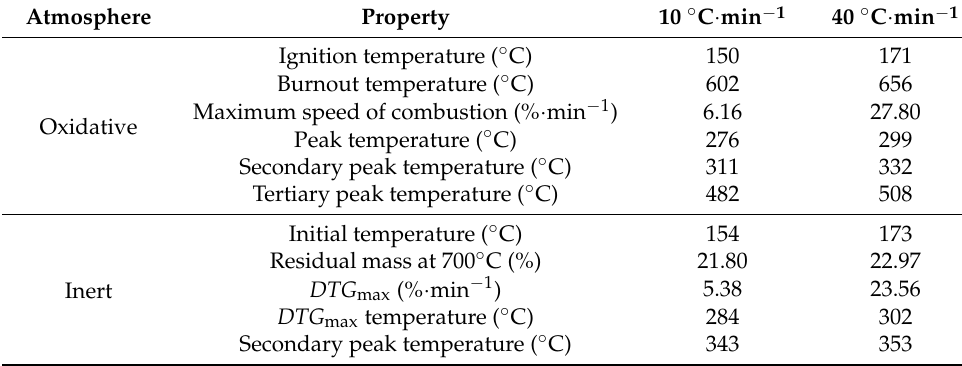
Table 4. TG analysis (TGA) parameters.